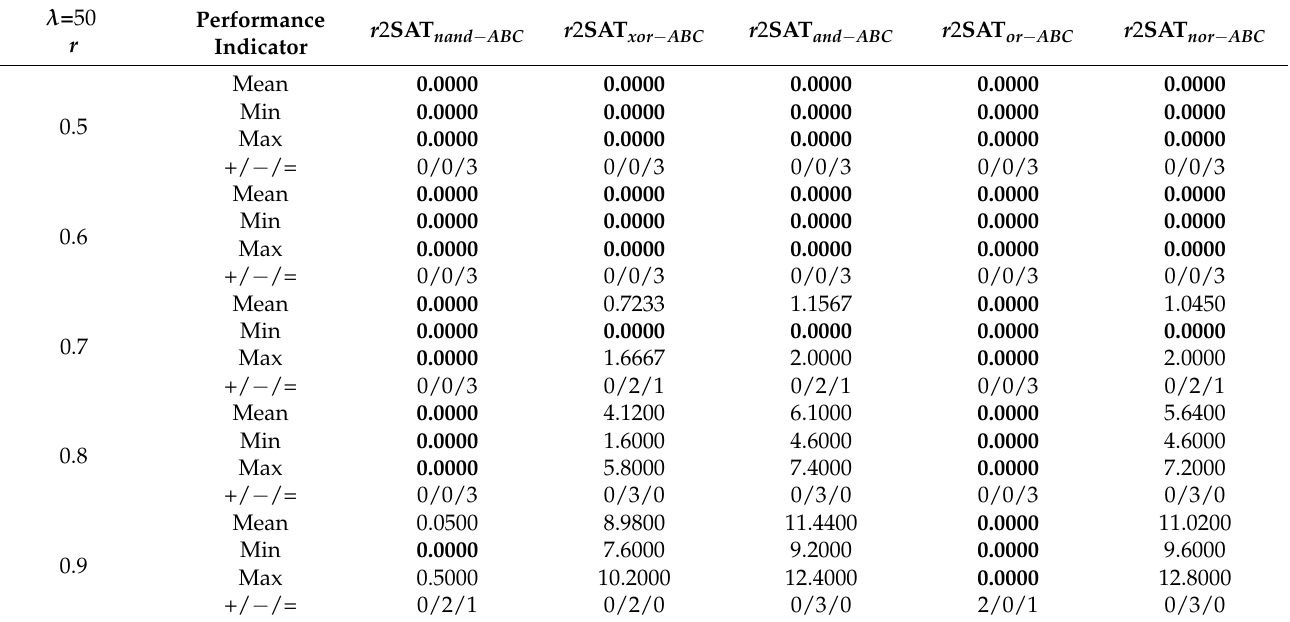
Table 13. Comparison of r 2SAT nand − ABC against other logic gates in terms of MAE for λ =